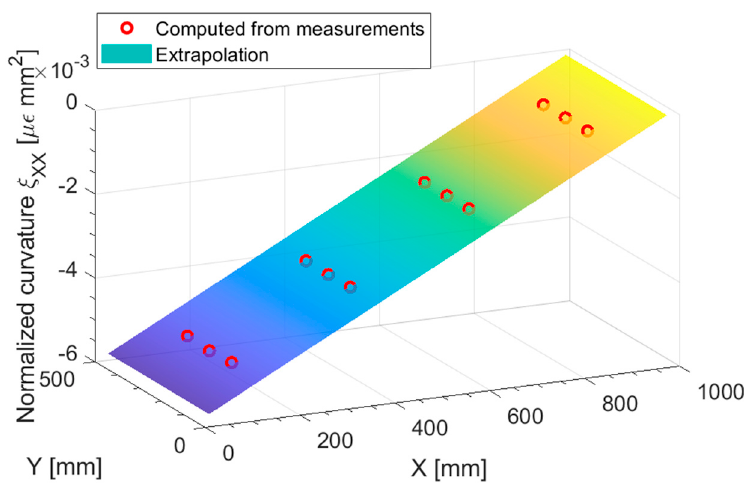
Figure 10. Out-of-plane tip loading: normalized curvature ξ XX